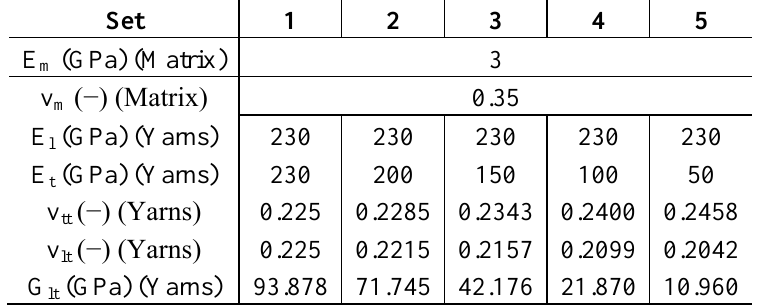
Table 1. Material properties of the constituents. The yarn properties are